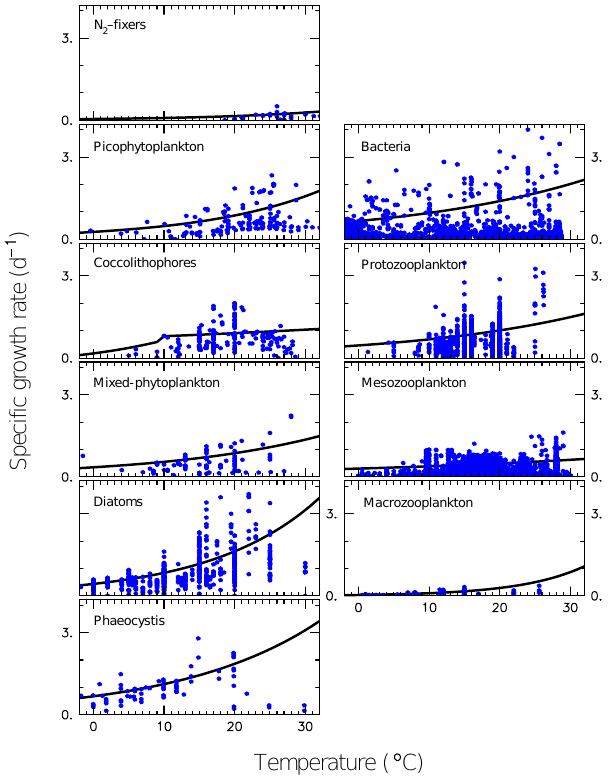
Figure 2. Maximum growth rates for 10 plankton functional types as a function of temperature for the phytoplankton PFTs (left) and for the heterotrophic PFTs (right). The PFTs are presented from the smallest (top) to the largest (bottom) in size. The fit to the data used in the model is shown in black, using the parameter values from Table 1. See Table 1 for